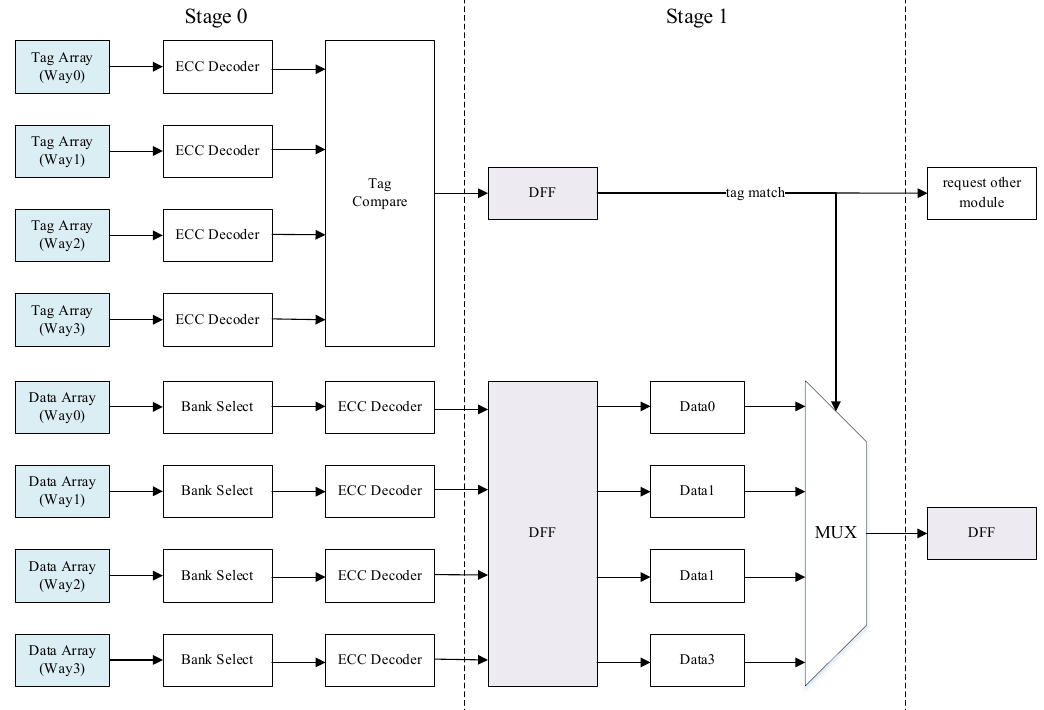
Figure 1. Conventional pipeline design scheme with ECC protection in cache.